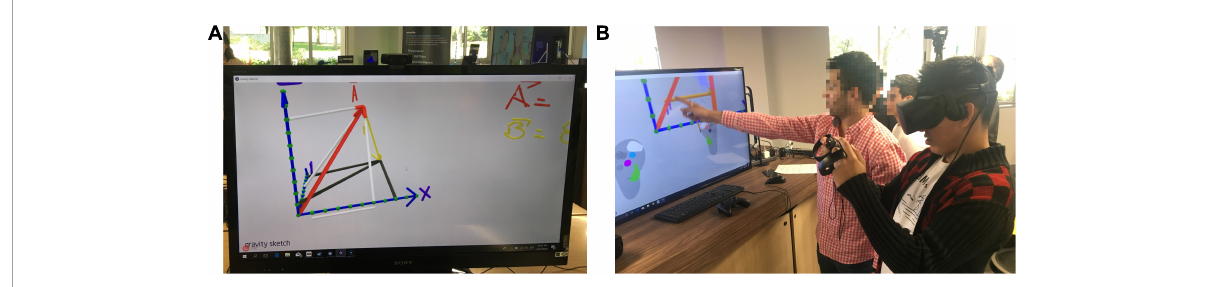
FIGURE1 Details of implementation with Gravity Sketch. (A) Example of vectors in Gravity Sketch. (B) Students interacting through the virtual reality (VR) goggles and with the